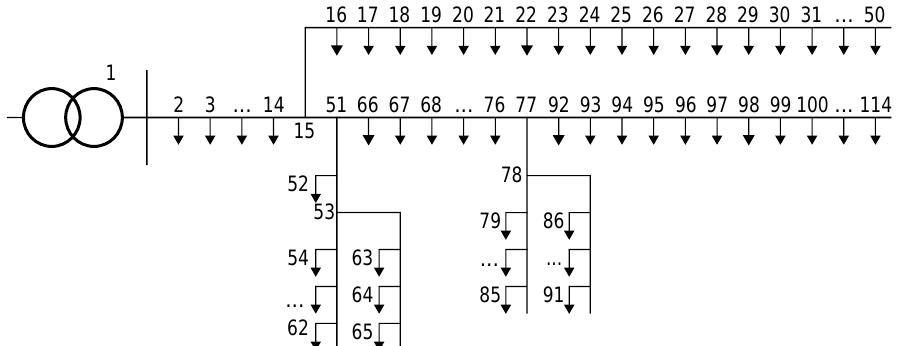
Figure 1. Single line diagram of the Distribution System Operator Observatory (DSOO) semi-urban low voltage grid #13 [12].